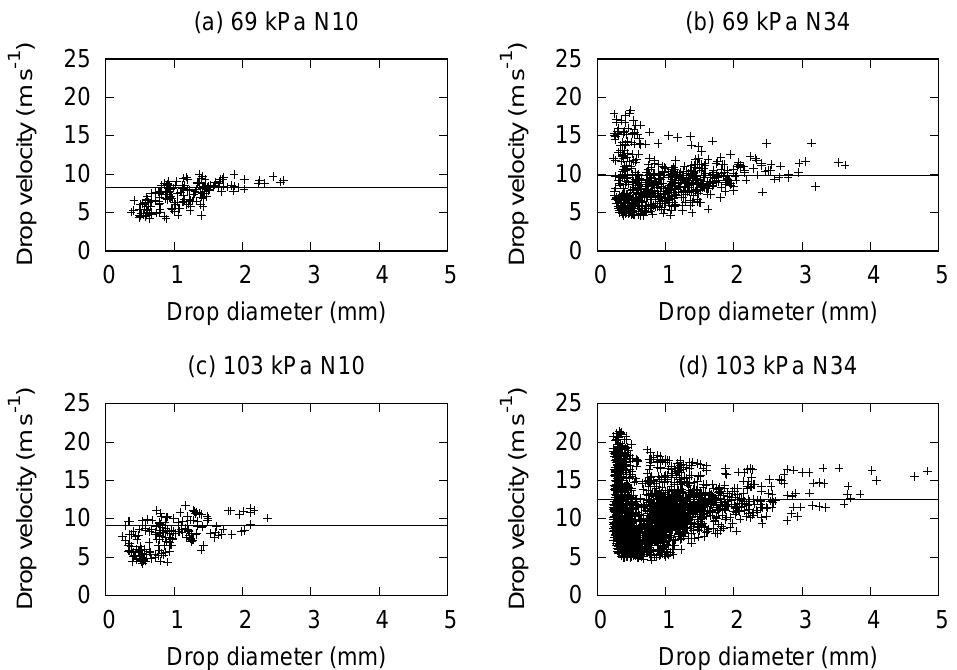
Figure 5. Measured drop diameter vs. measured drop velocity obtained with the PTV optical technique for the pressures of 69 kPa ( a , b ) and 103 kPa ( c , d ) (nozzle sizes N10-2.0 mm and N34-6.7 mm are shown). The continuous horizontal line represents the volumetric average drops velocity for each nozzle size and pressure.